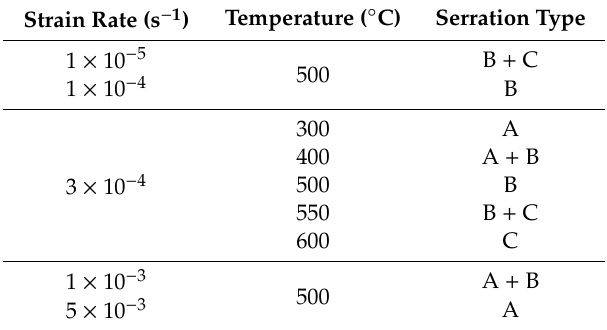
Figure 37. ( a ) The engineering stress vs. engineering strain curves for the sample tested at strain rates ranging from 1.0 × 10 − 5 to 5.0 × 10 − 3 s − 1 , at a temperature of 500 ◦ C. ( b ) The enlarged regions of ( a ) for engineering strain values ranging from 0.34 to 0.38 (reproduced from Reference [163] with permission). Table 6. Summary of the serration type exhibited by the CoCrFeMnNi HEA during tension at strain rates of 1 × 10 − 5 s − 1 –5 × 10 − 3 s − 1 and temperatures of 300–600 ◦ C (from Reference [163]).